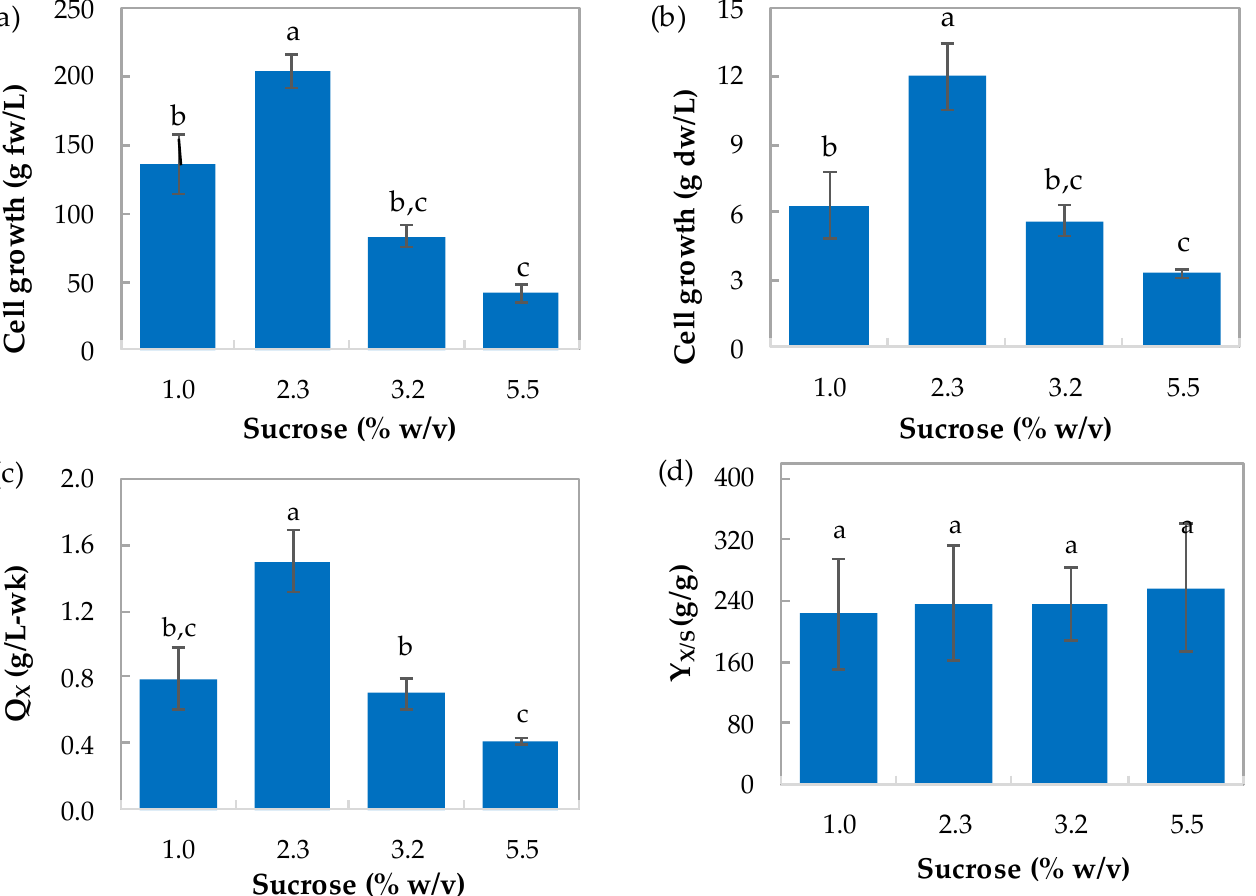
Figure 3. Growth kinetics expressed as dry weight (g/L) of Taraxacum officinale cell cultures main- tained in different growth media containing 1.0%, 2.3%, 3.2%, and 5.5% ( w / v ) sucrose for 12 weeks. Each value is the mean of three replicates.